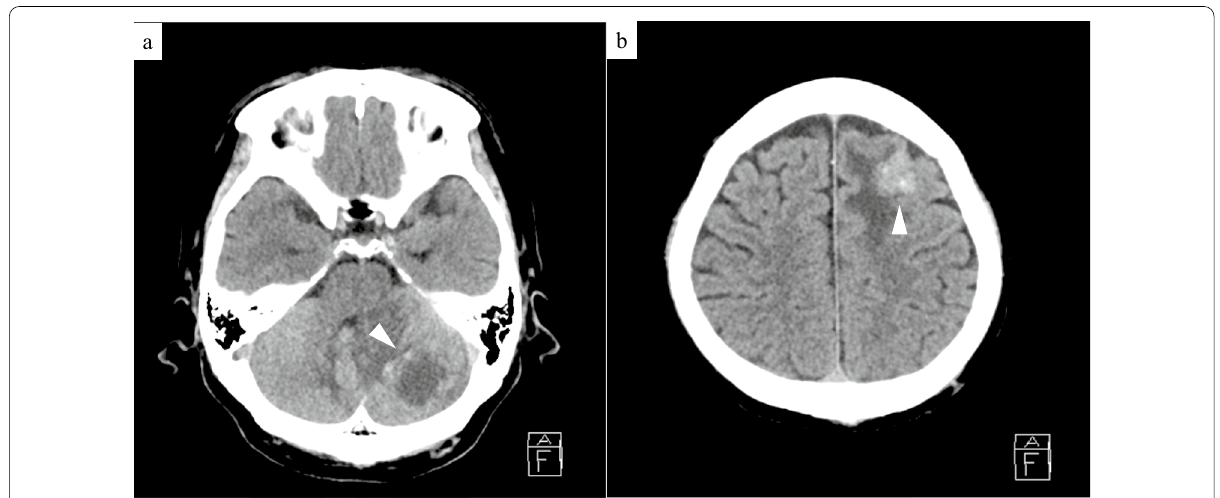
Fig. 2 Plain computed tomography (CT) of head. a Horizontal CT image: a left cerebellar hemisphere mass with surrounding edema is present (arrowhead). b Horizontal CT image: a left frontal lobe mass with surrounding edema is present (arrowhead)